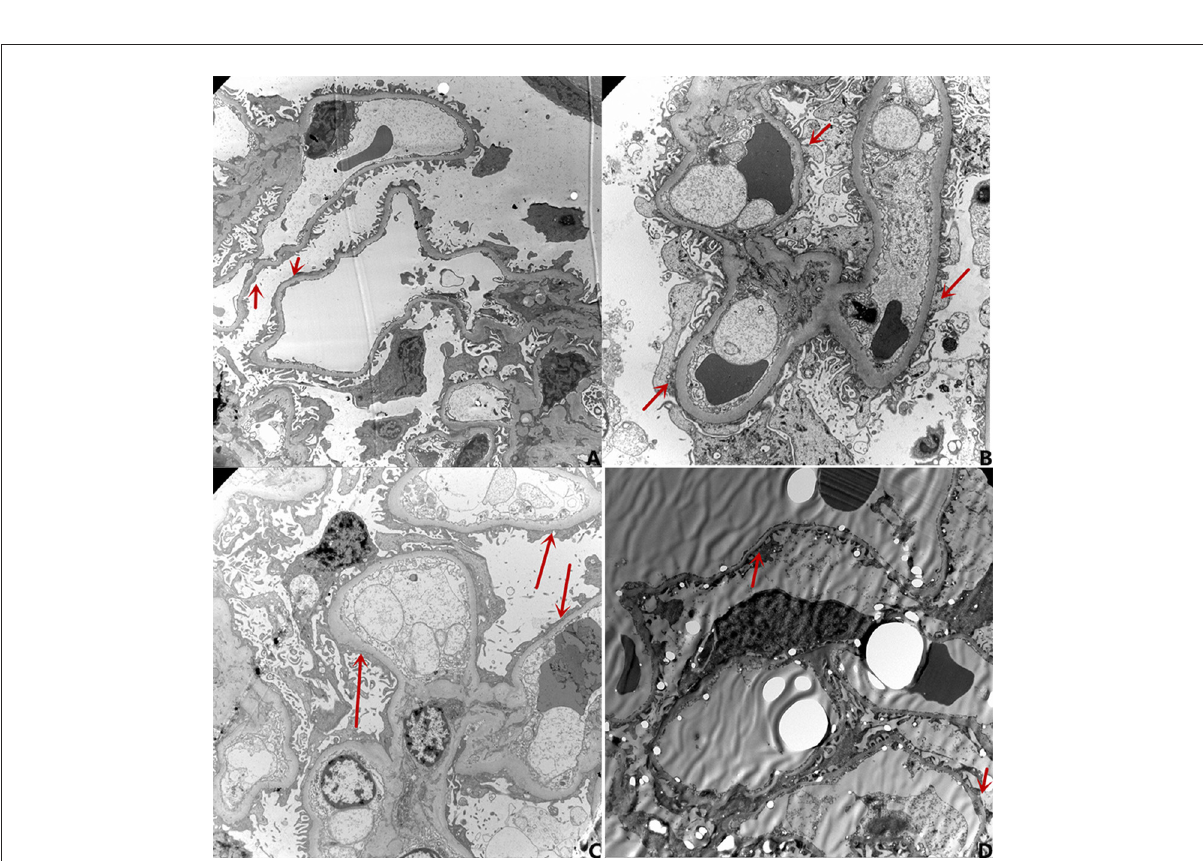
FIGURE2 The results of electron microscopy. (A) Urine protein: 4.28g/d, Degree of foot process effacement: 95%; (B) Urine protein 0.09 g/d (with negative conversion for 4 days), Degree of foot process effacement: 85%; (C) Urine protein 0.15 g/d(with negative conversion for 7 days), Degree of foot process effacement: 80%; (D) Urine protein 0.01 g/d(with negative conversion for 90 days), Degree of foot process effacement: